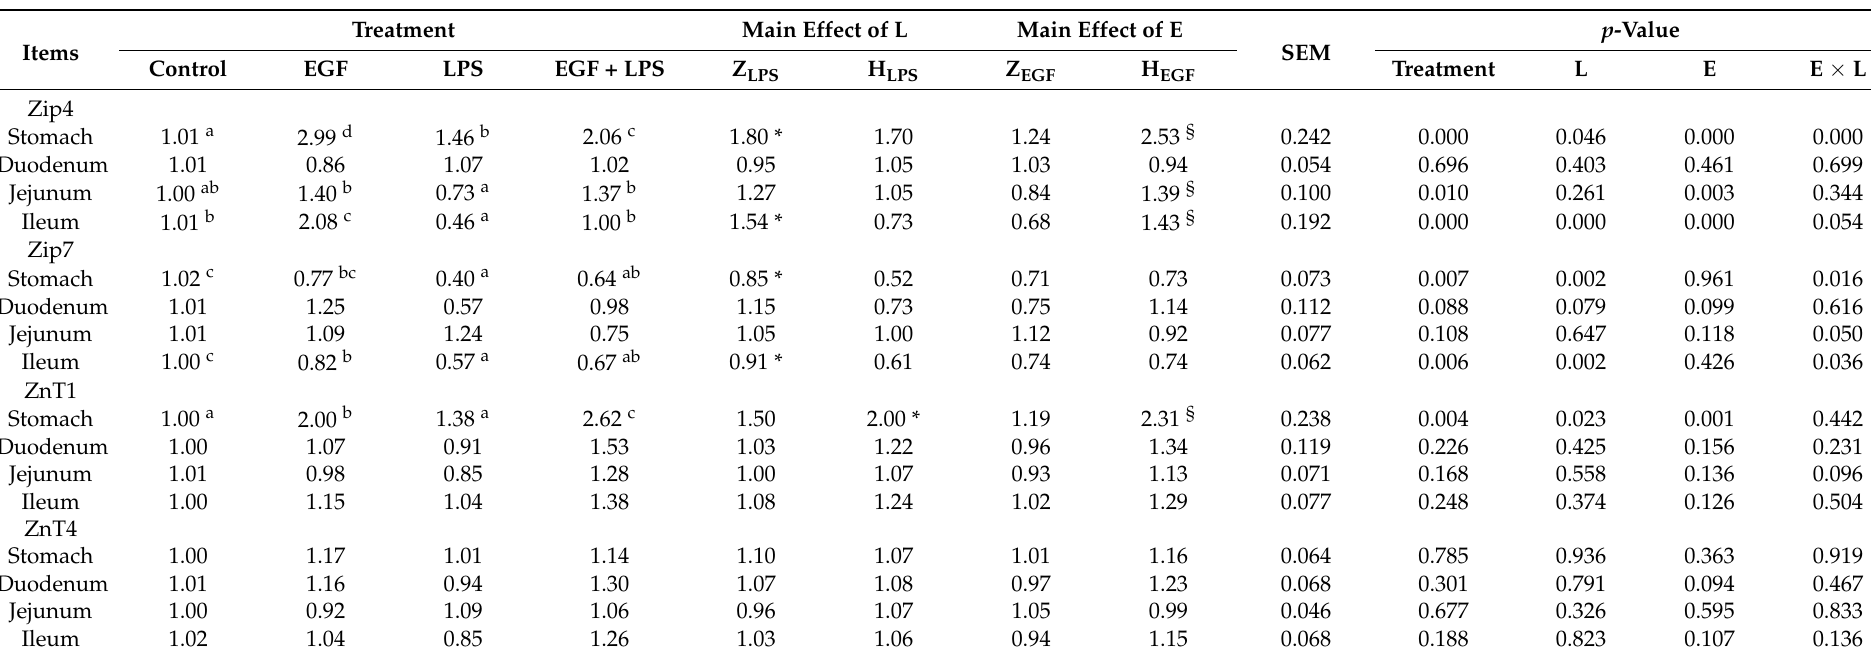
Table 8. EGF attenuates the effect of LPS on the expression levels of Mn transport-relative genes in the mucosa of gastrointestinal tract of early-weaning